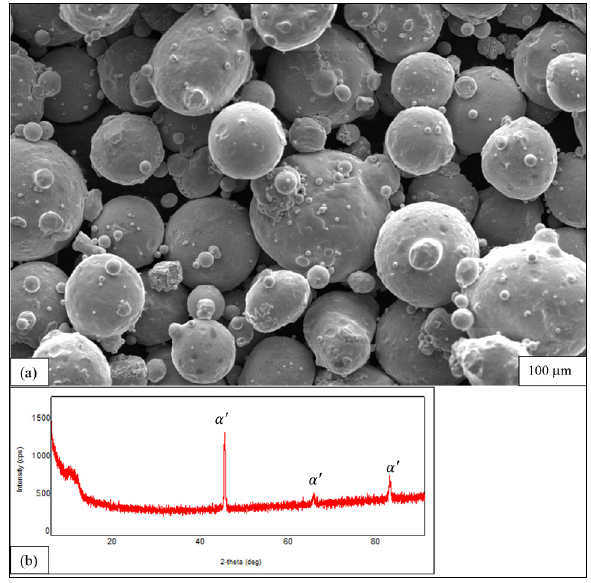
Figure 1: 17-4PH powder: (a) scanning electron micrograph and (b) X-ray diffraction spectrum.